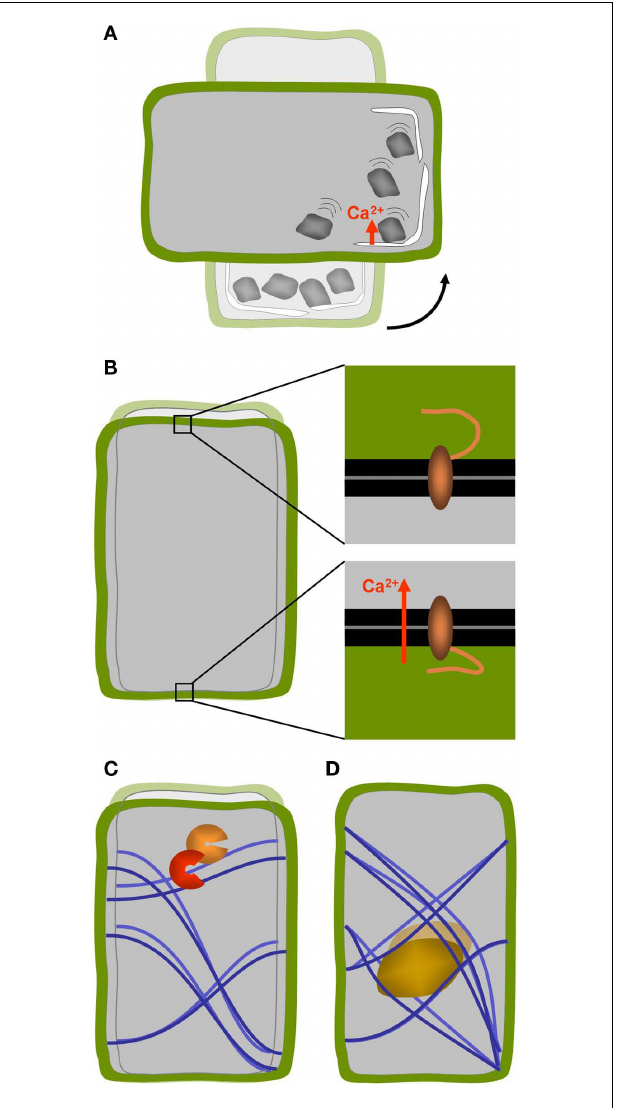
FIGURE 2 | Concepts of cellular gravisensing in plants. (A) In statolith-based gravisensing the sedimentation or change of position of intracellular organelles with higher density triggers a signal most likely based on a change in trans-membrane ion fluxes. (B) According to the gravitational pressure model the weight of the protoplast causes the forces acting on the membrane–cell wall connections at the upper and lower sides of the cells to be different. (C) The tensegrity model predicts that cellular distortion due to a change in g -force affects the pre-stress in the cytoskeletal array of the cell which in turn changes biochemical activities. (D) A variation of the tensegrity model is based on a change in cytoskeletal pre-stress being caused by the weight of heavy organelles that are tethered to the cytoskeletal filaments such as the nucleus.